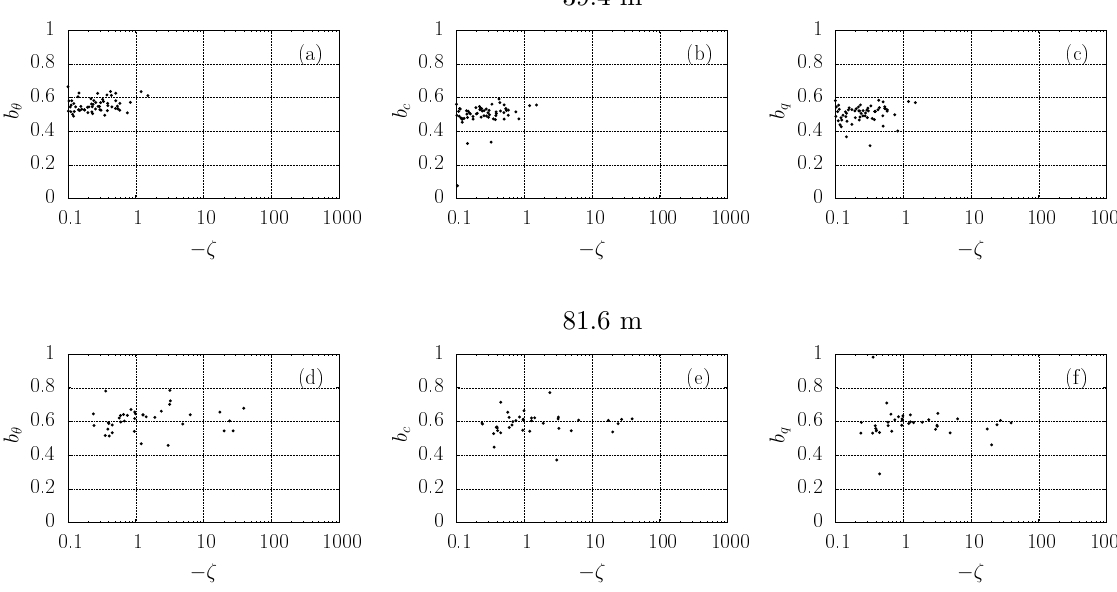
Figure 10. Relaxation coefficient from eddy accumulation method, where (a, d) are temperature, (b, e) are CO 2 , and (c, f) are water vapor. 39.4 m